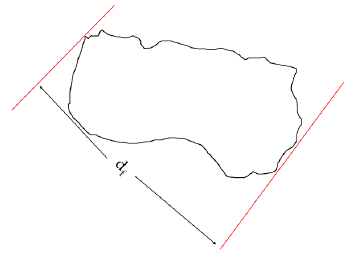
Figure 16. An illustration of the Feret diameter of a particle.